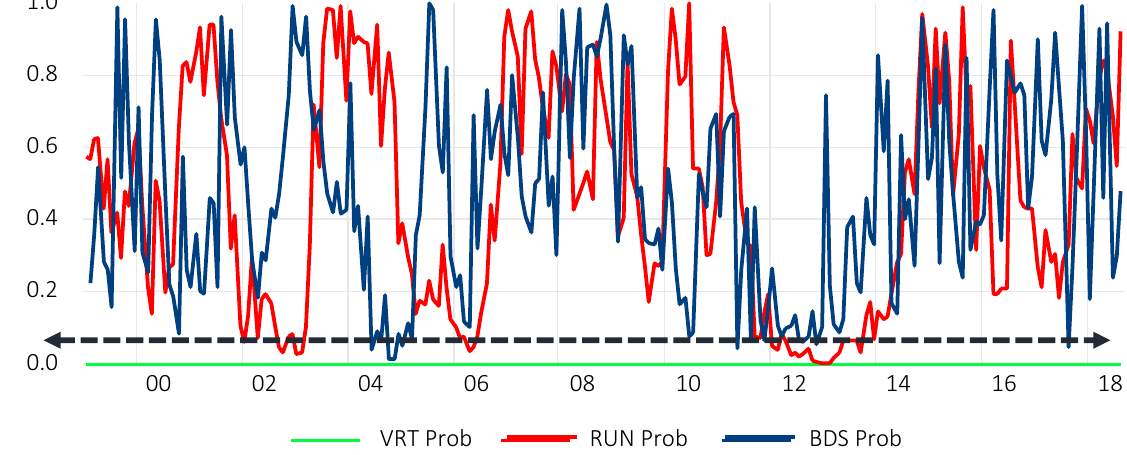
Figure 1. ZARUSD VR, runs and BDS p -values (2-year window, rolled by 1-month)